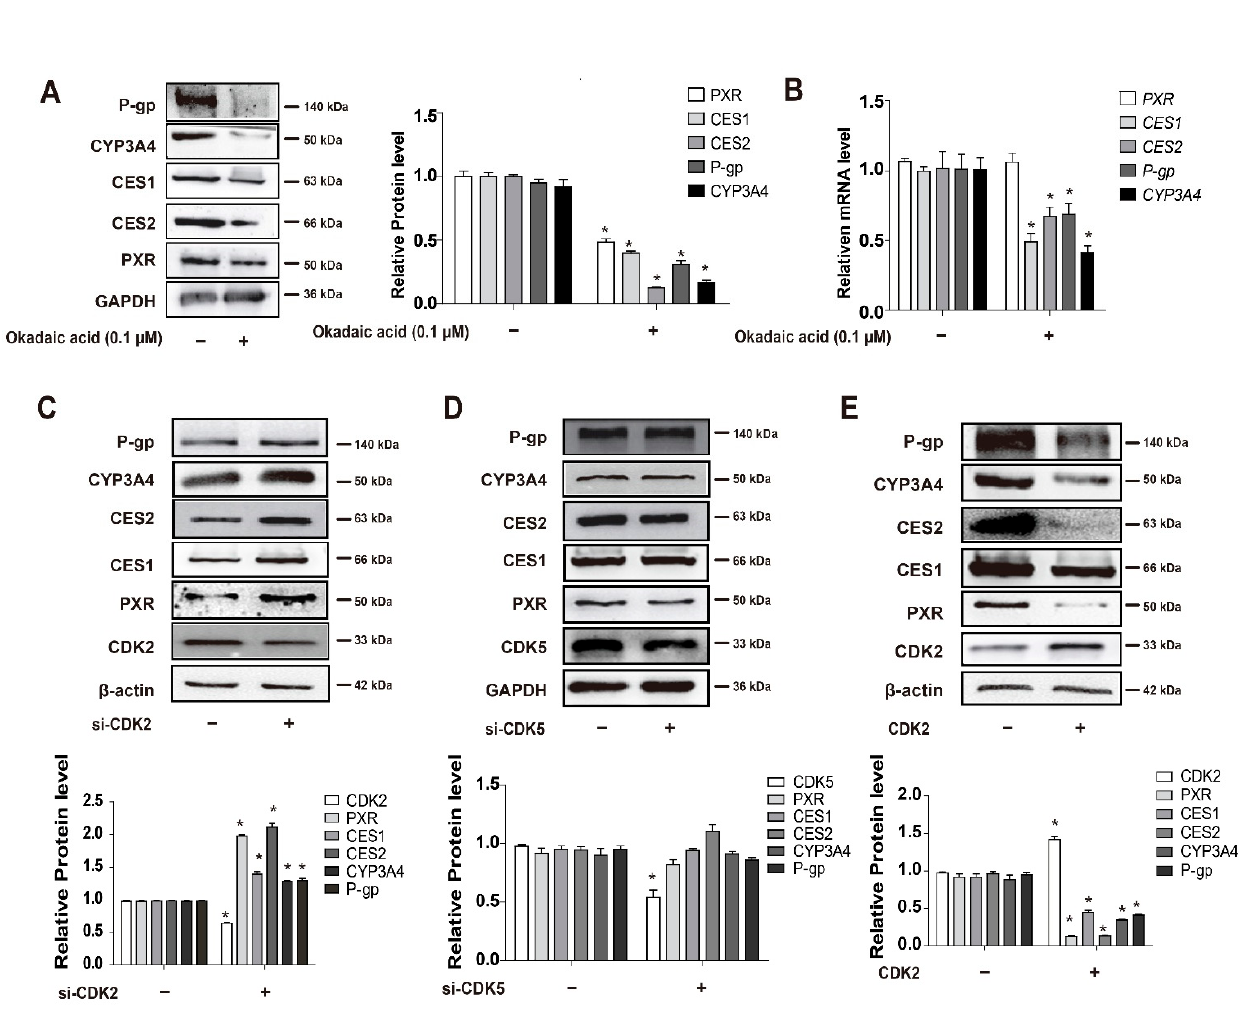
Figure 4. CDK2-mediated phosphorylation destabilizes PXR protein and suppresses PXR-targeted genes expression. ( A,B ) HepG2 cells were treated with okadaic acid (0.1 μ M) for 24 h, and the gene expression was analyzed at protein ( A ) or mRNA levels ( B ). Cell lysates were prepared and subjected to Western blot to determine the expression of PXR, CES1, CES2, CYP3A4 and P-gp, respectively. mRNA levels were detected by qRT-PCR. ( C,D ) HepG2 cells were transfected with si-CDK2 or si-CDK5 and siRNA-control for 48 h. Cell lysates were prepared and subjected to Western blot to determine the expression of PXR, CES1, CES2, CYP3A4 and P-gp, respectively. ( E ) The effect of CDK2 overexpression on the sup- pression of CES1, CES2, PXR, CYP3A4 and P-gp. Experiments described in this figure were repeated independently at least three times, and data are expressed as mean ± SEM ( n = 3). * p < 0.05 indicates significant difference compared with control